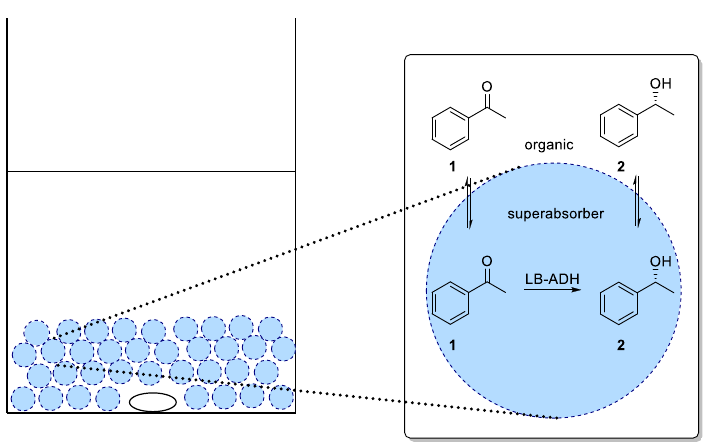
Figure 4. Schematic batch reaction of acetophenone ( 1 ) to alcohol ( R )- 2 in a superabsorber system. To gain a better understanding of this system, batch experiments screening di ff erent parameters were carried out. The conversion was monitored by gas chromatography (GC) analysis and the results after a reaction time of 25 h were compared. Di ff erent organic solvents, amounts of superabsorber, enzyme loadings, and bu ff er-to-organic solvent ratios were investigated. All aqueous solutions (ADH, GDH, NADPH, and glucose each in bu ff er) were mixed and immobilized by addition of superabsorber. After a short incubation of 5 min, a 100 mM acetophenone ( 1 ) solution in MTBE was added. All reactions ◦ were carried out at 25 C. The results were compared to a bu ff er / MTBE system without immobilization (Figure 5).